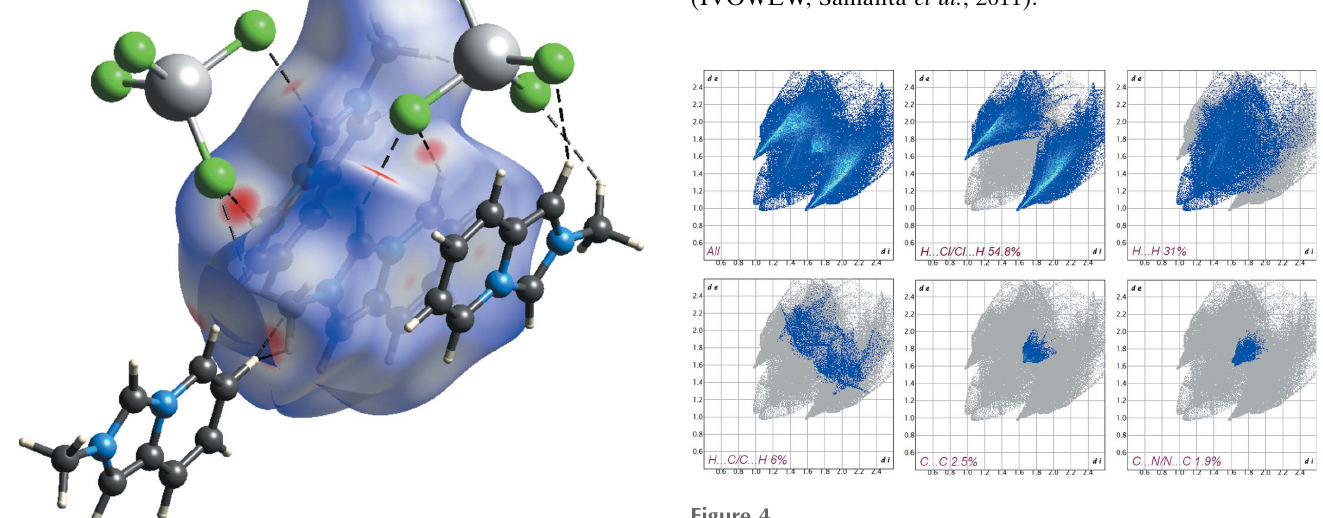
Figure 3 HS mapped over d norm for the L + cations in [ L ] 2 [MnCl 4 ] ( I ).